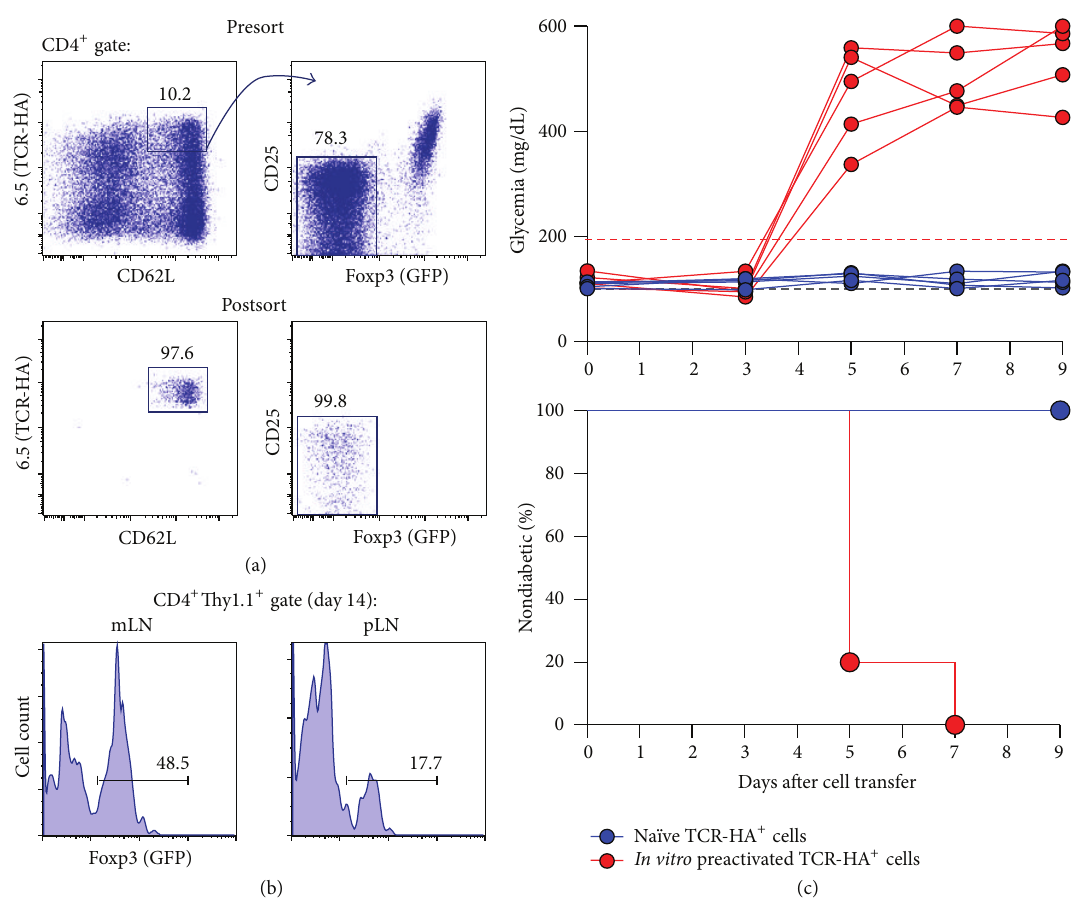
Figure 1: Adoptive TCR-HA + T cell transfer into immunocompetent RIP-HA mice. (a) Using the clonotypic antibody 6.5, na¨ıve TCR-HA + T cells (CD 4 + 6.5 + CD 62 L high CD25 − GFP − ) were FACS purified from BALB/c.Thy1.1 TCR-HA × Foxp 3 IRES-GFP mice, after CD4 bead enrichment of pooled cells from spleen and LNs. Presort (top) and postsort (bottom) analyses of TCR-HA/CD62L (left) and CD25/GFP (right) expression among CD4-gated cells are depicted. The gating scheme is illustrated by the line with arrowhead. For antigen-specific stimulation in vitro , peptide (10 𝜇 g/mL). As indicated, na¨ıve or in vitro TCR-HA + T cells were cultured as previously described [7], in the presence of HA 107 – 119 preactivated TCR-HA + T cells were injected i.v. into immunocompetent BALB/c.Thy1.2 RIP-HA mice. (b) Flow cytometry of Foxp 3 IRES-GFP expression among gated CD4 + Thy1.1 + cells at day 14 after adoptive transfer into BALB/c.RIP-HA recipient mice (mLN: mesenteric lymph node; pLN: pancreatic LN). Numbers in dot plots or histograms indicate the percentage of cells in the respective gate. (c) Blood glucose concentrations (top) and diabetes incidence (bottom) of BALB/c.RIP-HA mice injected with na¨ıve (blue circles, 𝑛 = 5 ) or in vitro preactivated TCR-HA + T cells (red circles, 𝑛 = 5 ). Blood glucose concentrations (in mg/dL) of individual mice were determined every other day and plotted against time. The grey dashed line indicates normoglycemia. Mice were considered diabetic at blood glucose levels above 200 mg/dL (red dashed line) on at least two consecutive measurements or with blood glucose levels once above 400